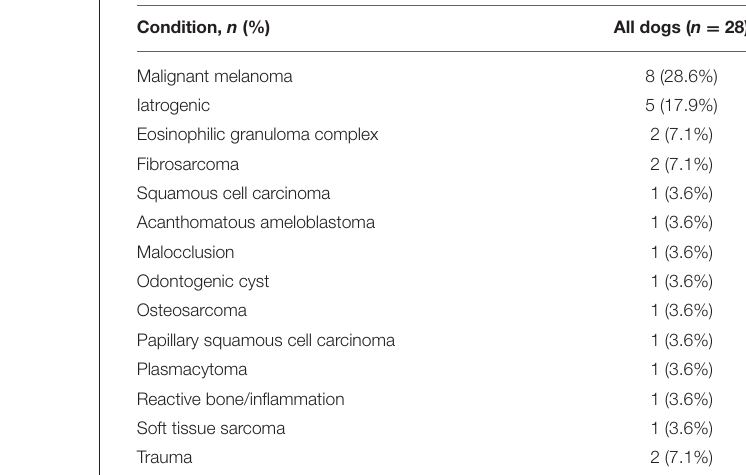
TABLE 2 | Conditions represented in study